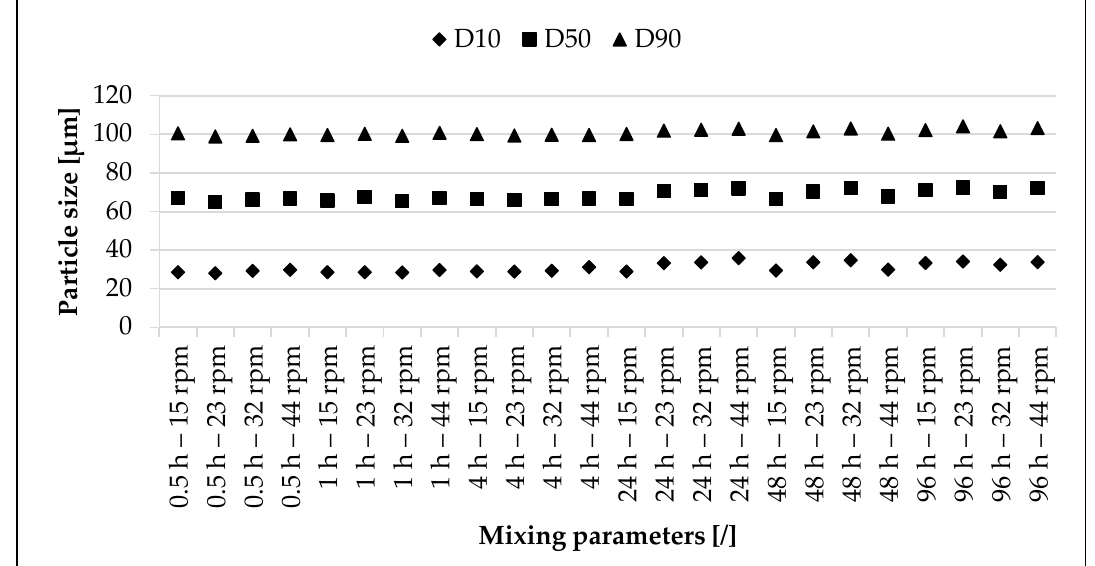
Figure 5. Influence of the mixing process on the characteristic values of the particle size distribu- tion. Six mixing durations with four mixing intensities in each case are considered. Determined with Camsizer XT.